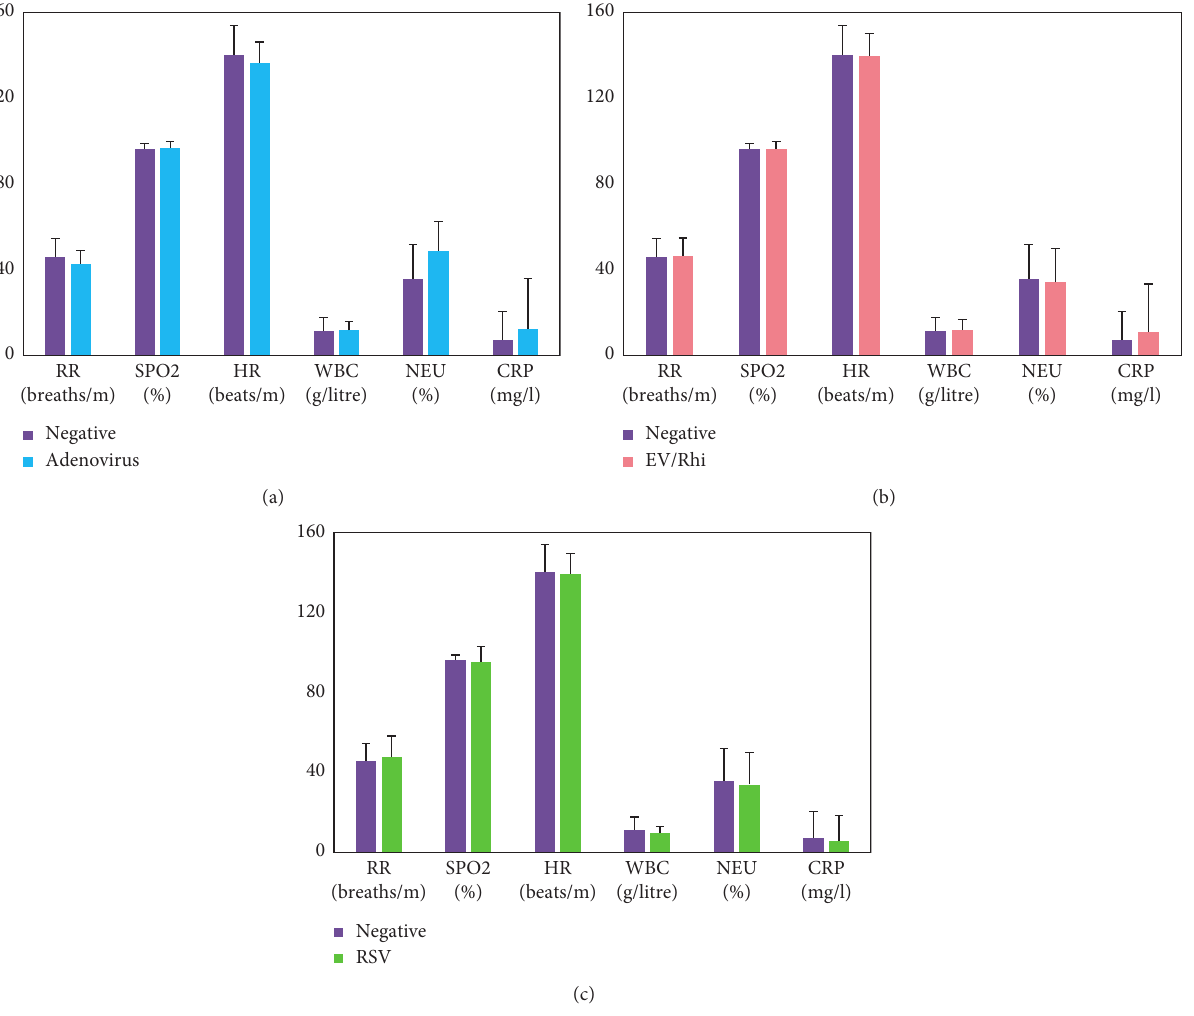
Figure 3: Bar graphs showing the association between specific viral infection and subclinical and clinical signs. (a) Comparison of clinical data between adenovirus infection and the negative group. (b) Comparison between enterovirus/rhinovirus infection and the negative group. (c) Comparison between respiratory syncytial virus (RSV) infection and the negative group. RR: respiratory rate; SPO 2 : peripheral capillary oxygen saturation; HR: heart rate; WBC: white blood cell count; NEU: neutrophil count; CRP: C-reactive